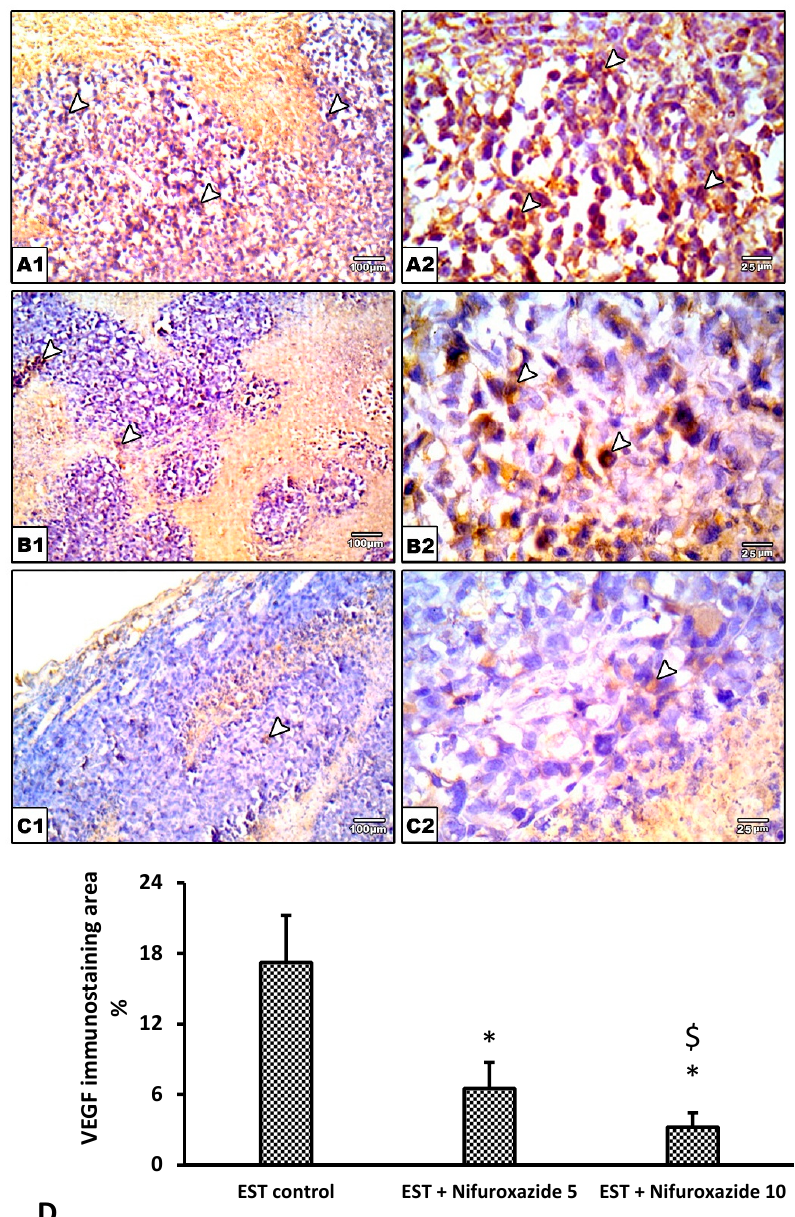
Figure 10. Photomicrographs for sections from tumors immunostained for VGEF. Images show high positive staining in EST (arrow heads) ( A ). A significant reduction in VGEF level was detected in nifuroxazide-treated groups ( B , C ) as evidenced by a weaker brown staining (arrow heads). IHC counterstained with Mayer’s hematoxylin. X: 100, bar 100 ( A1 , B1 , and C1 ), X400 ( A2 , B2 , and C2 ), bar 25. ( D ) Bar char representing the normalized VEGF immunopositively, data are mean ± S.D. and compared at P less than 0.05. * Versus the EST control, $ Versus the EST + Nifuroxazide (5 mg/kg) group. EST: Ehrlich solid tumors, VEGF: vascular endothelial growth factor.